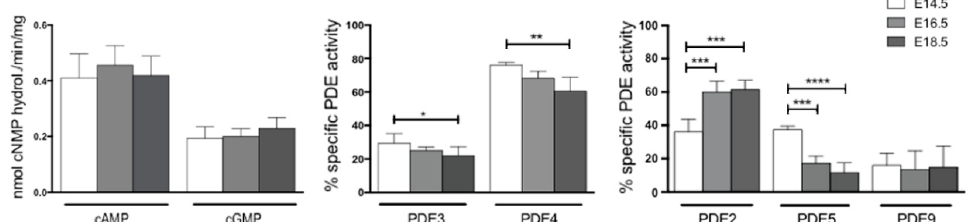
Figure 3. Total and specific PDE enzymatic activity during heart formation. Total cAMP and cGMP hydrolyzing activity from heart homogenates at E14.5 (white columns), E16.5 (light grey columns) and E18.5 (dark grey columns). PDE3- and PDE4-specific activities are reported as a percentage of total cAMP hydrolyzing activity evaluated after adding a fixed dose of the specific inhibitor milrinone and rolipram, respectively (see Materials and Methods). PDE2, PDE5 and PDE9 specific activities as a percentage of the total cGMP hydrolyzing activity evaluated after adding a fixed dose of the specific inhibitor BAY 60-7550, sildenafil and PF04449613, respectively (see Materials and Methods). Data represent the mean of three independent experiments ± SD. Each experiment was performed with a pool of 5 hearts per stage. One-way ANOVA was used for statistical analysis. * p < 0.05, ** p < 0.01, *** p < 0.001, **** p <